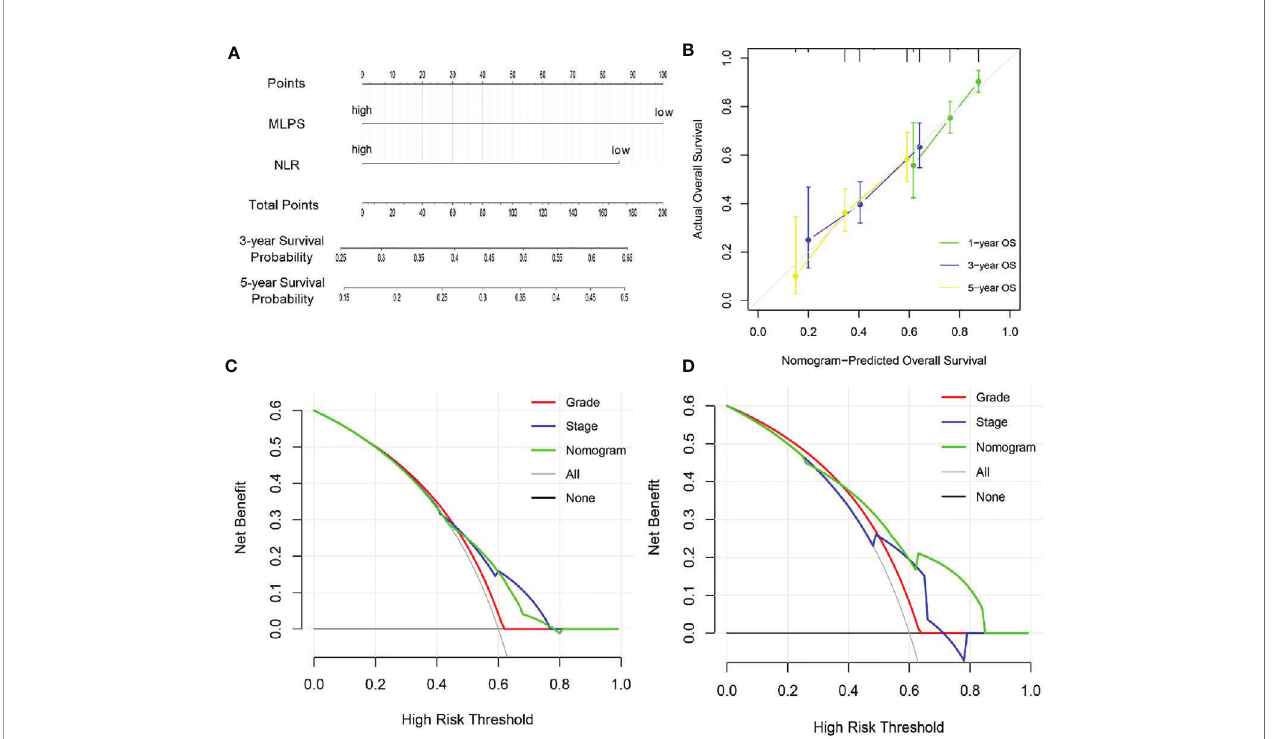
FIGURE 4 | Construction and evolution of a prognostic nomogram based on MLPS and NLR. (A) Nomogram based on MLPS and NLR for BCa patients in the TCGA cohort. (B) Calibrate plot evaluating the nomogram-predicted probabilities of 1-, 3- and 5-years survival with the actual overall survival. (C, D) Decision curve analyses comparing overall survival bene fi ts among the nomogram, tumor grade and stage in the TCGA cohort and the General cohort, respectively. MLPS, machine learning-based pathomics signature; NLR, neutrophil to lymphocyte ratio; BCa, bladder cancer; TCGA, The Cancer Genome